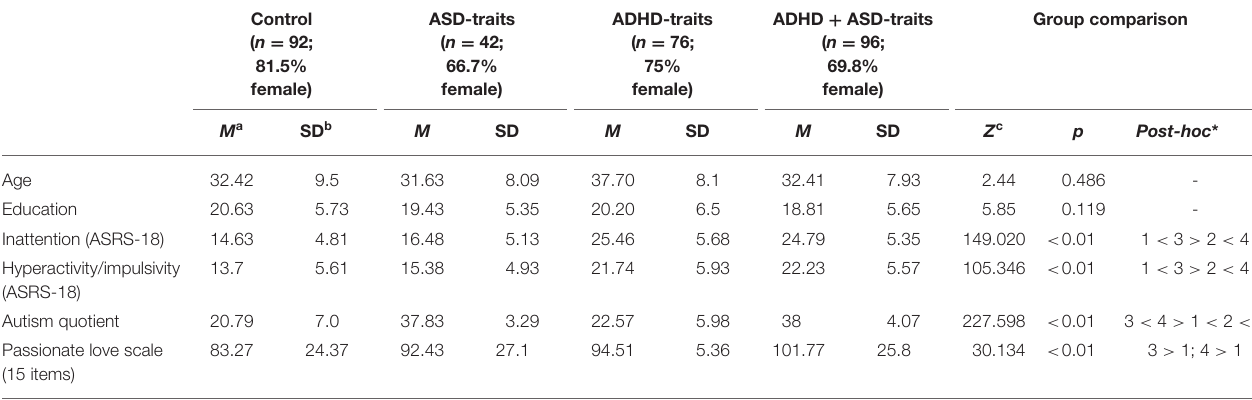
TABLE 1 | Participant’s description and group comparison.